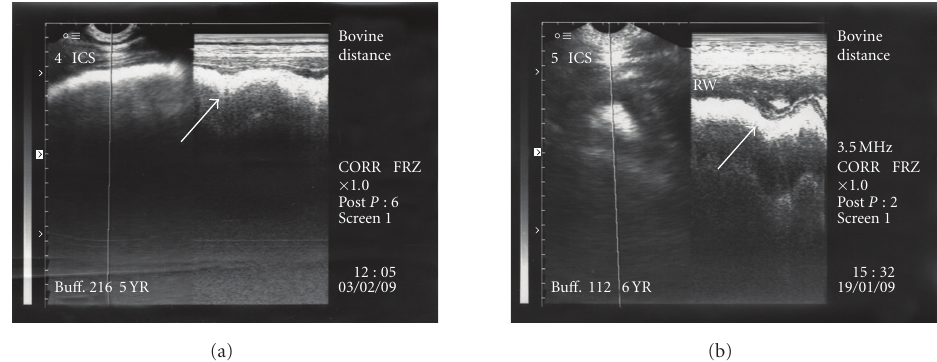
Figure 9: Gliding reticular motility in the thoracic cavity cranial to the 5th intercostal space visualized on B+M mode ultrasonograms (arrow) confirmatory for diaphragmatic hernia.